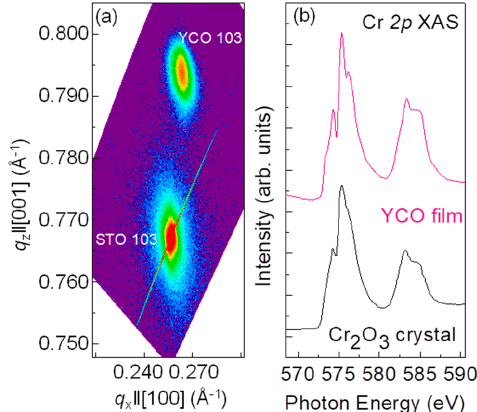
Figure 2. ( a ) Reciprocal space map (RSM) of asymmetric scans around the (103) reflection of STO